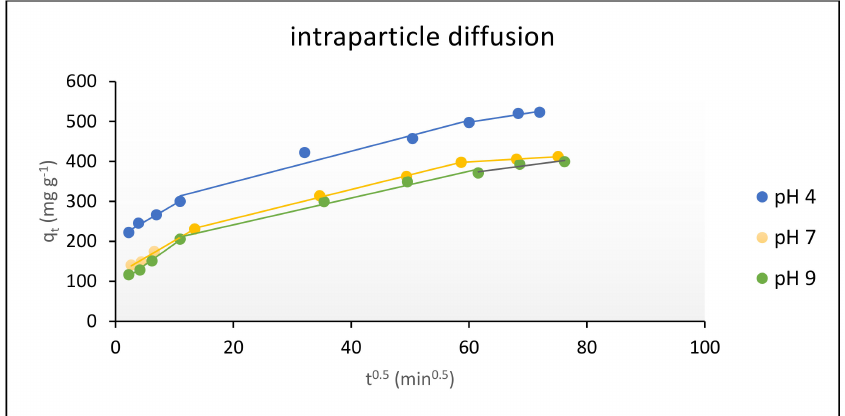
Figure 11. The intraparticle diffusion plots for adsorption of CR dye onto UCs using different pH values.